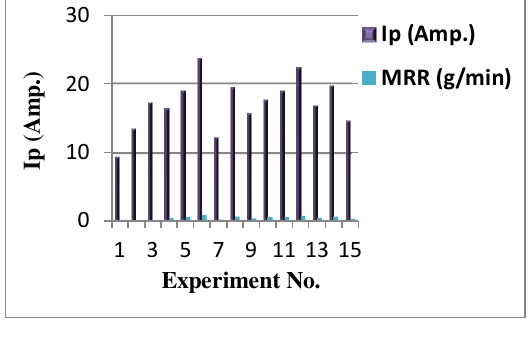
Fig. 8. Effect of current intensity on MRR.